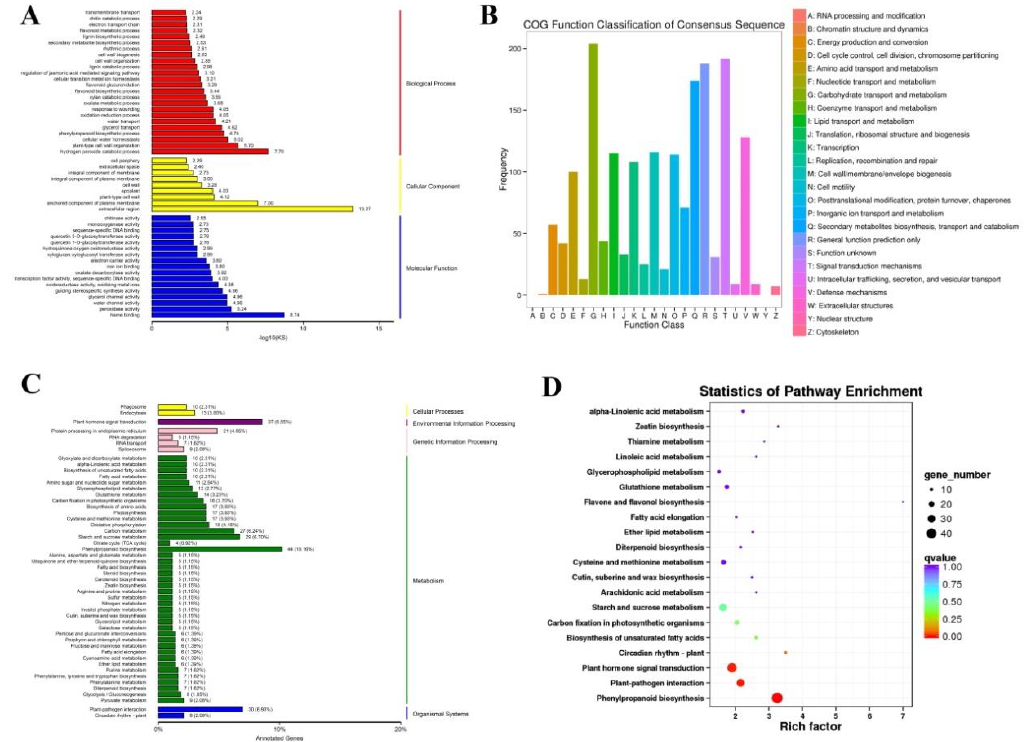
Figure 2. ( A ) Gene ontology (GO) classification of DEGs. Red, yellow, blue terms belong to biological processes, cellular components, and molecular functions, respectively. ( B ) COG function classification of DEGs. Di ff erent colored columns represent di ff erent functional classifications. ( C ) KEGG classification of DEGs. Di ff erent pathways are showed by di ff erent columns. The number of DEGs per pathway is quantified by the height of the column. ( D ) KEGG enrichment of DEGs. The number of DEGs is distinguished by the size of the circle and the circle from blue to red represents the q-value from large to